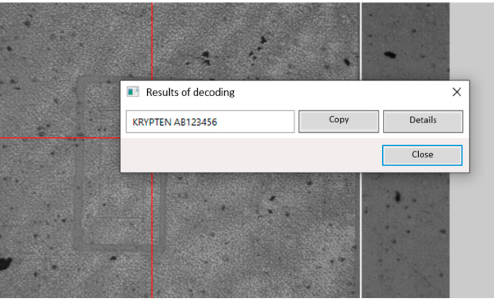
Figure 14. Result of successful decoding.